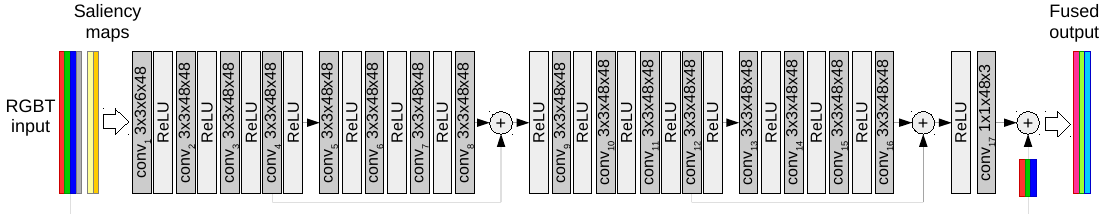
Figure 2. The architecture of the fusion network is an array of high-resolution convolution layers with residual blocks. The input is a concatenation of the input RGB+Thermal channels and saliency maps computed on the luminance of the RGB and on the thermal intensity. The fused result is obtained by adding the residual output of the network to the original RGB